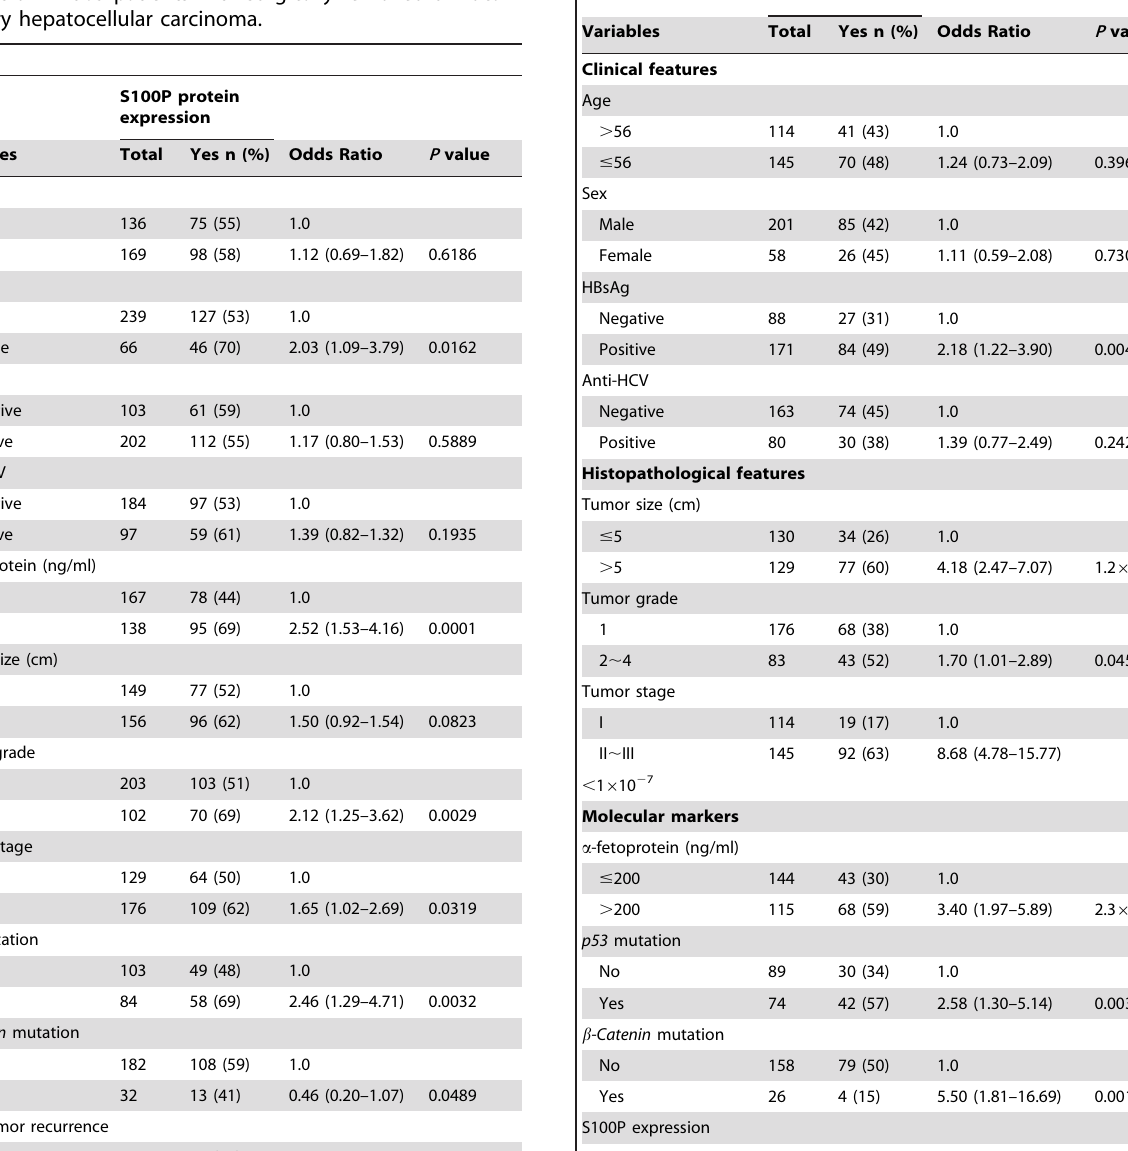
Table 1. Univariate analysis of S100P protein expression with various clinicopathological features and aberrant gene expression in 305 patients with surgically removed unifocal primary hepatocellular carcinoma.